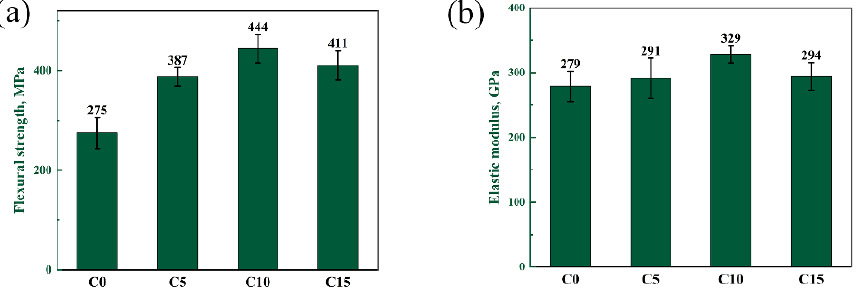
Figure 10. ( a ) Flexural strength and ( b ) elasticity modulus of composites with different carbon contents.